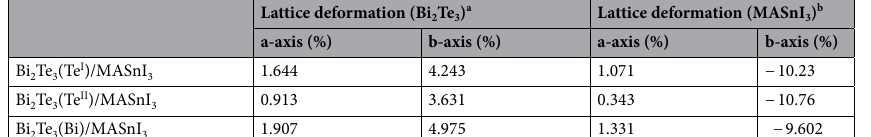
Lattice deformation (Bi 2 Te 3 ) a